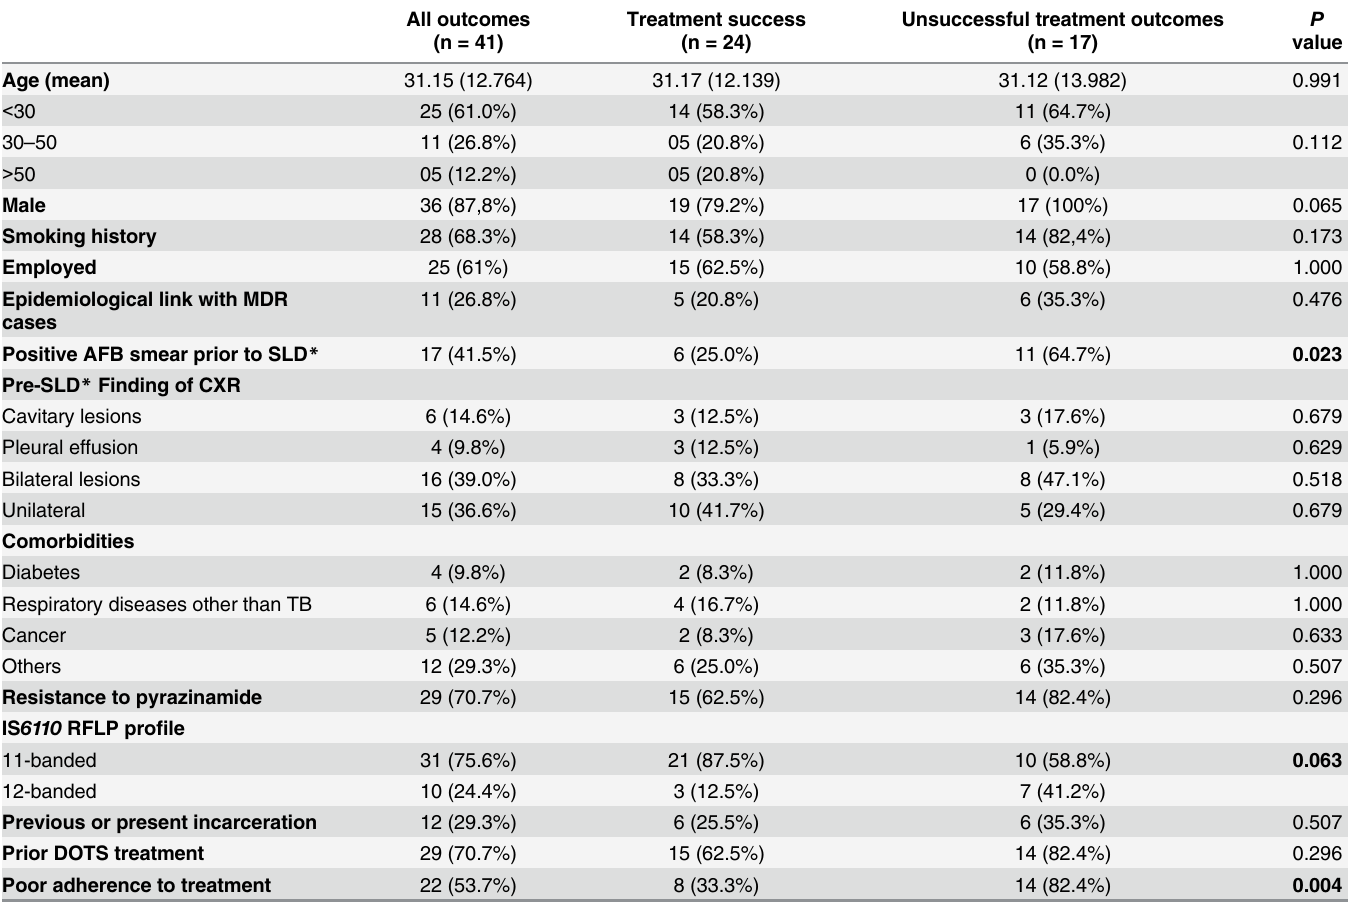
Table 2. Clinical outcomes for the 41 Haarlem3 MDR-TB outbreak patients that had received a 2-year second line anti-TB